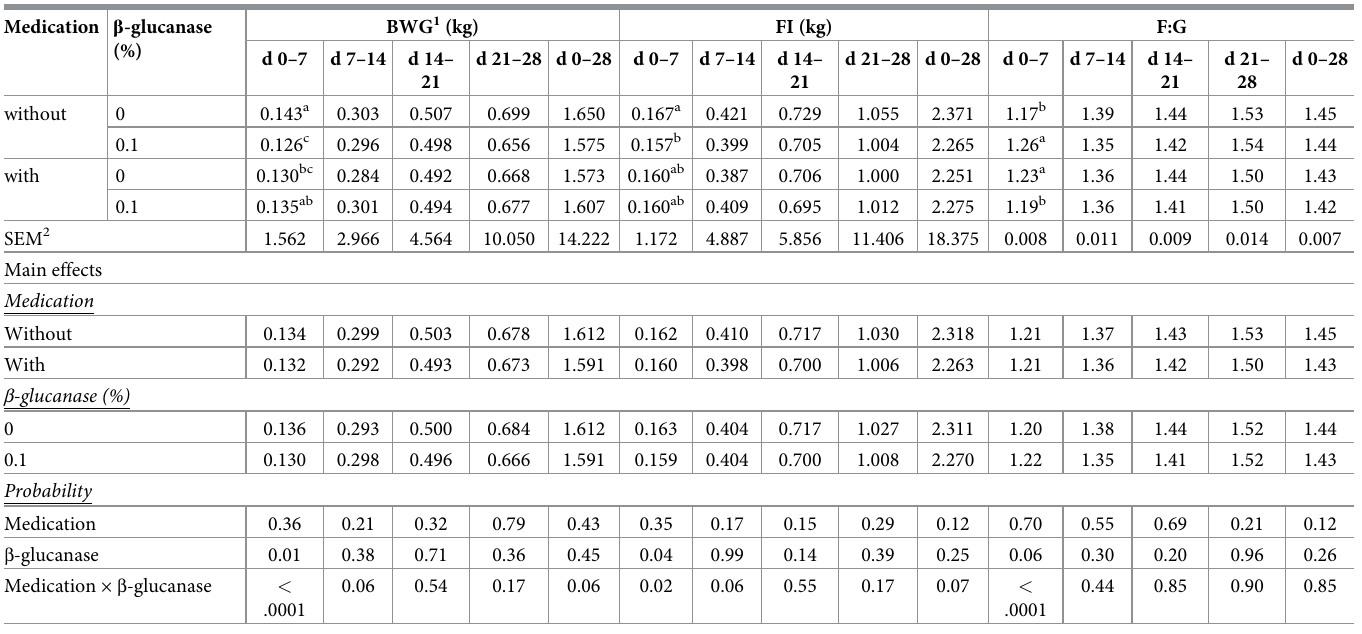
Table 9. Effects of diet medication and β -glucanase on body weight gain, feed intake and feed efficiency of broiler chickens (Experiment 1). Medication β -glucanase